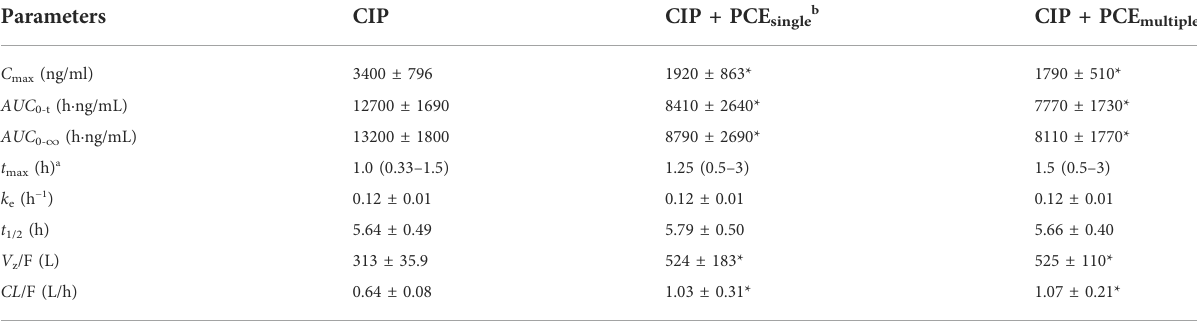
TABLE 1 Pharmacokinetic parameters of cipro fl oxacin after the oral administration of cipro fl oxacin hydrochloride tablets (CIP, 0.5 g) with and without PCE (8 g) to human subjects (mean ± SD, n = 12).